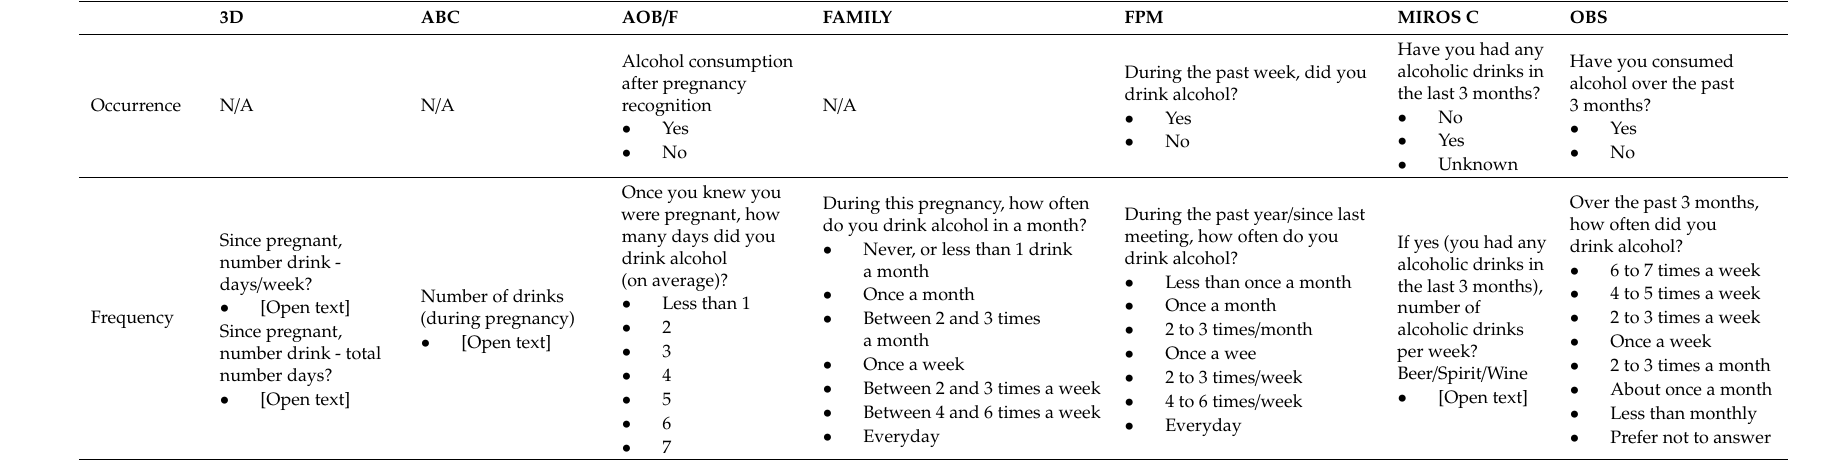
Table 2. Questions used to capture data about alcohol use and response categories, during pregnancy.